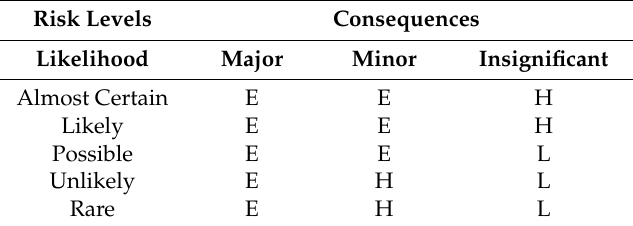
Table 4. Risk levels (E: Extreme, H: High, L: